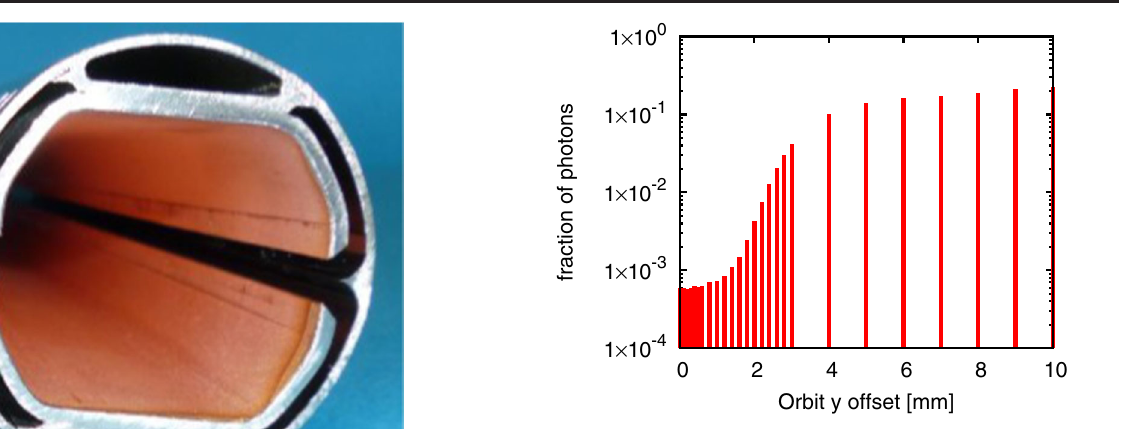
FIG. 9. Simulated fraction of photons absorbed on the inner FCC-hh beam screen as function of the peak vertical orbit